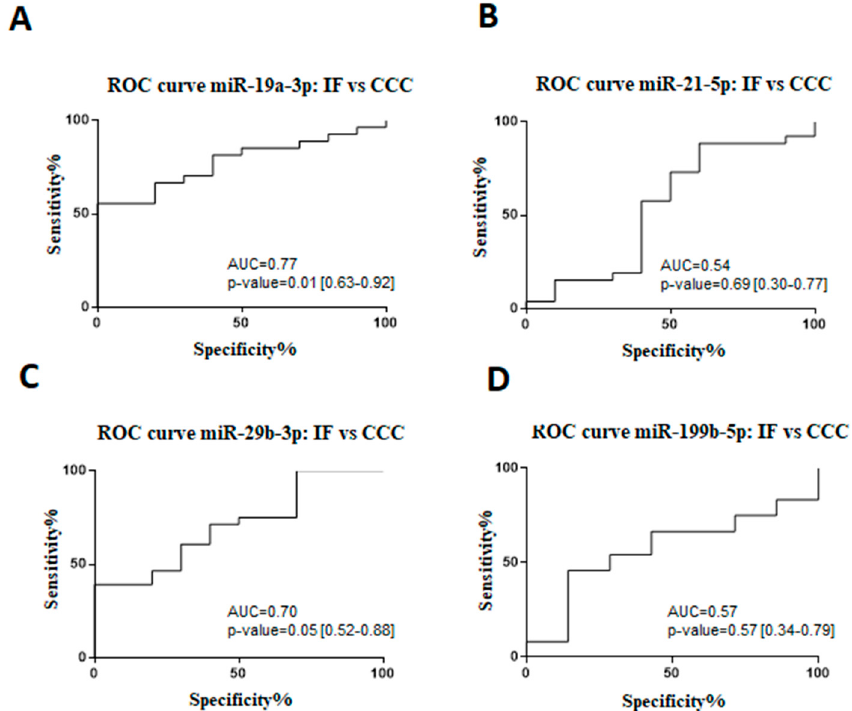
Figure 2. Receiver operating characteristic (ROC) curve for the prognosticating Chagas disease progression. ROC analysis of miRNA expression in serum from chronic Chagas disease subjects, indeterminate form (IF) vs chronic Chagas cardiomyopathy (CCC): ( A ) miR-19a-3p, ( B ) miR-21-5p, ( C ) miR-29, and ( D ) miR-199b-5p expression, measured by RT-qPCR. The miRNA values were standardized for statistical analysis. The area under the curve (AUC) with 95% CI and P value were represented in the figure. p < 0.05 indicate statistical significance.